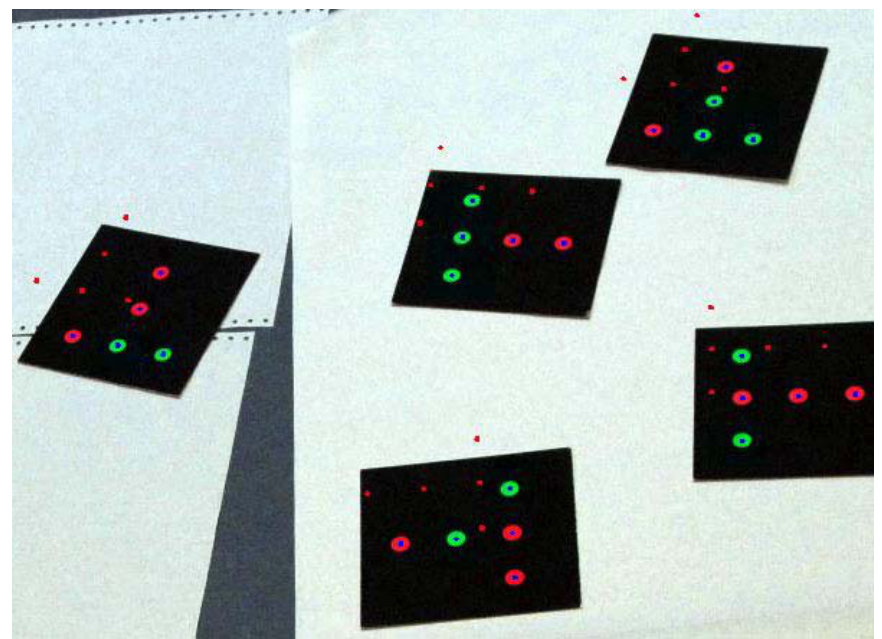
Figure 9. Small red dots illustrate the initial orientation and blue dots the registration after the interactive orientation and the inverse transformation of 3D points according to the relative orientation